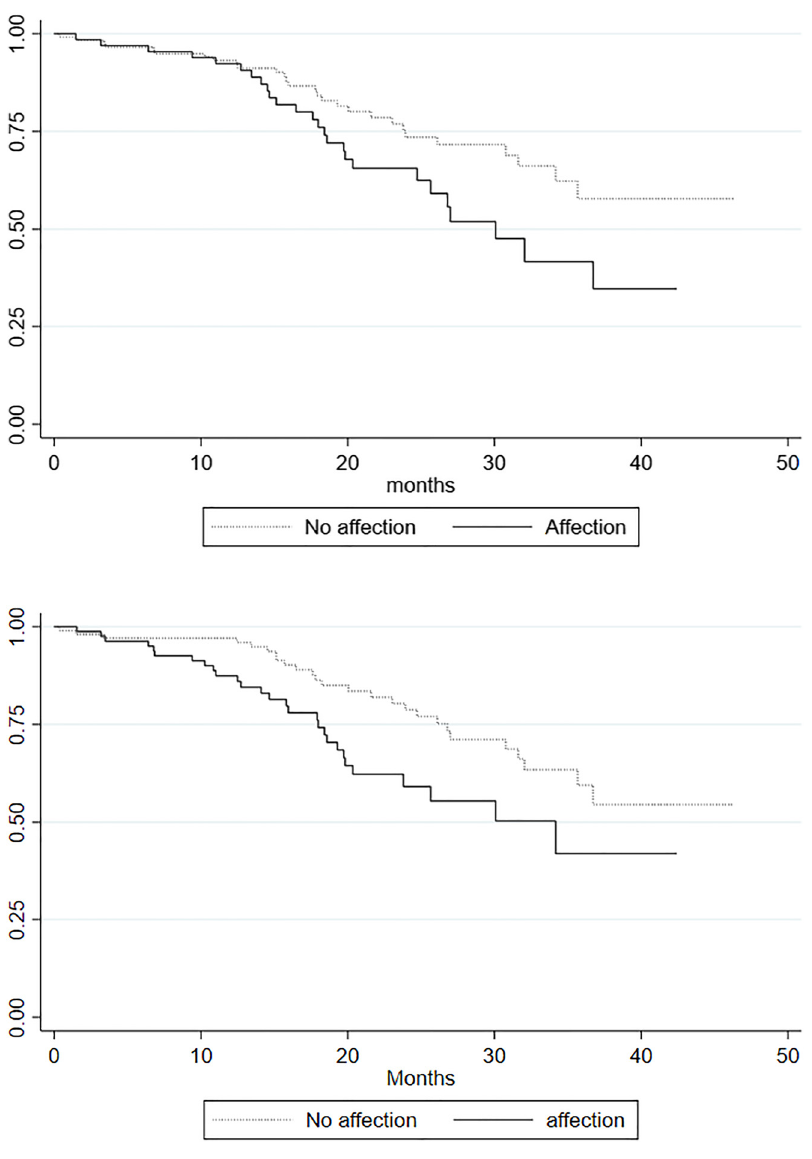
Figure 4: Survival by ileocolic